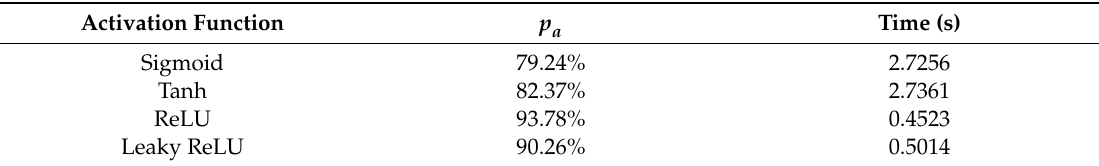
Table 3. Selection of activation